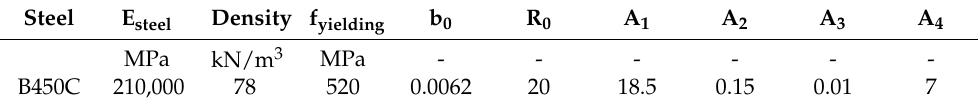
Table 2. Un-corroded steel reinforcement Menegotto-Pinto